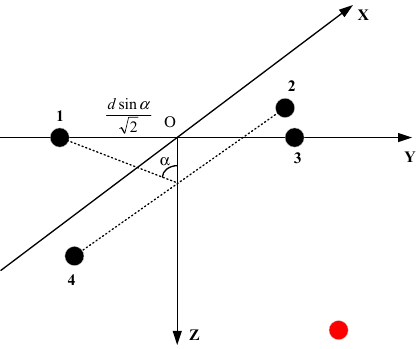
Figure 2. The four-element stereo array 1. Here, the distance between array elements 2 and 4 is 2 d . The depth of array elements 1 and 3 is always 0. The angle between edge 12 and edge 14 remains unchanged at 90°. The coordinates of the four elements are(0, α ). The center of the array is considered to be at the coordinate origin. The red dot shows the location of the source. The distance between the source and the center of the array is r . The azimuth of the incident signal is θ pitch is .The coordinates of the source can be expressed as ( sin cos r ϕ ). The unit vector of source direction is ( sin